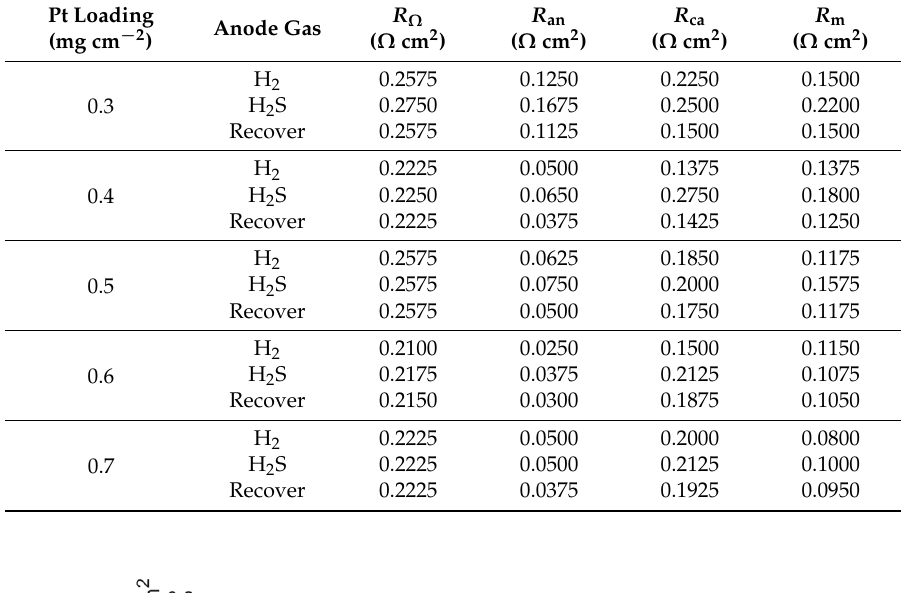
Table 1. Fitted resistances of membrane electrode assemblies (MEAs) with various anode Pt loadings under different gases.